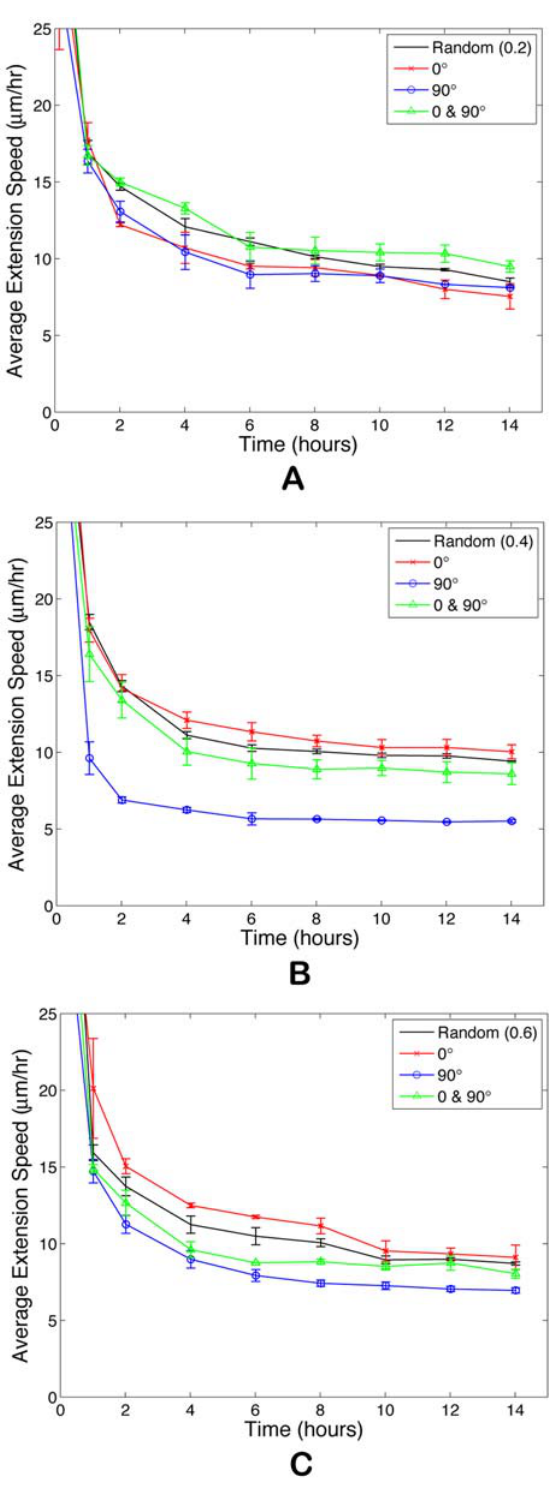
Figure 4. Evidence that mechanical cues, or contact guidance, from the ECM affects sprout extension. (A) At r ~ 0 : 2 , fiber network is not well connected and matrix fiber alignment does not have a strong effect on sprout extension speeds. At r ~ 0 : 4 (B) and r ~ 0 : 6 (C), rates of sprout extension are more rapid when matrix fibers are aligned parallel to VEGF gradients (0 u ) than when matrix fibers are aligned perpendicular to the gradient (90 u ).